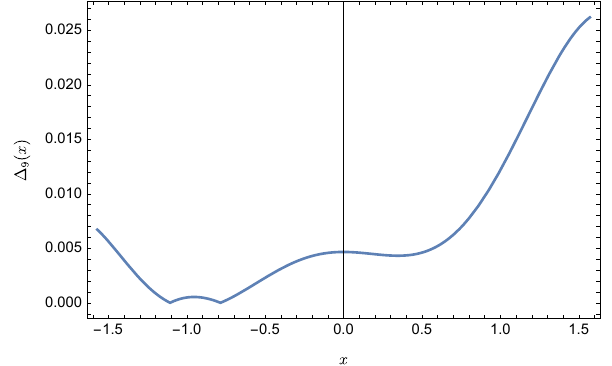
Figure 4. Error ∆ 9 of approximation y 9 ( x )